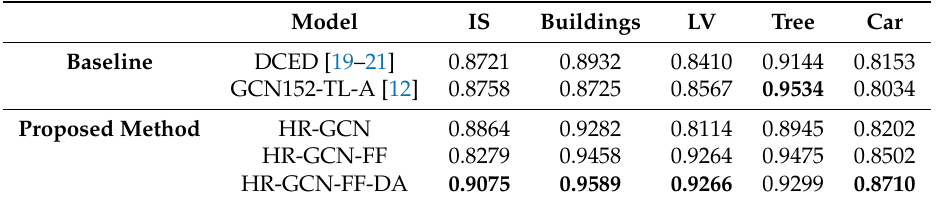
Table 8. Effects on the testing set of ISPRS Vaihingen (Stuttgart) challenge data set among each class with our proposed procedures in terms of AverageAccuracy